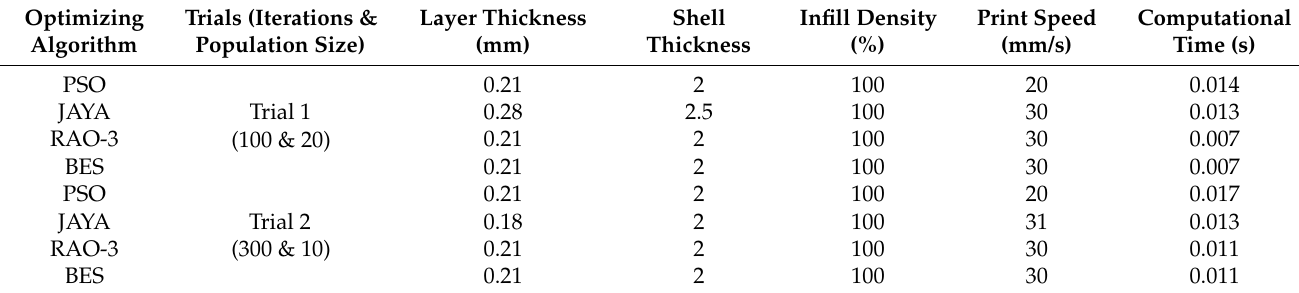
Table 6. Summary of results of the optimal fused deposition modeling